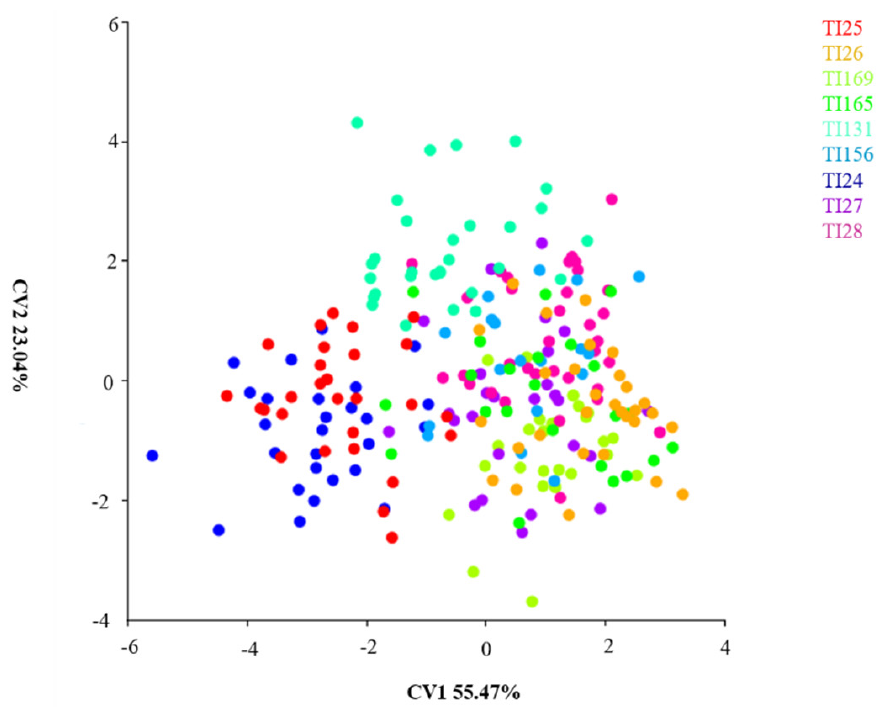
Figure 6. Canonical variance analysis of T. infestans populations from different localities. TI24 (Guarani das Missões/RS/BR); TI25 (Argentina/Cordoba); TI26 (Argentina/Sta. Fe); TI27 (Entre Ijuís/RS/BR); TI28 (Sto. Cristo/RS/BR); TI131 (Sta. Rosa/RS/BR); TI156 (Sta. Rosa/residual foci/RS/BR); TI165 (Cochabamba/Bolívia); TI169 (Tremedal/residual foci/BA). BR-BRAZIL, RS—Rio Grande do Sul.